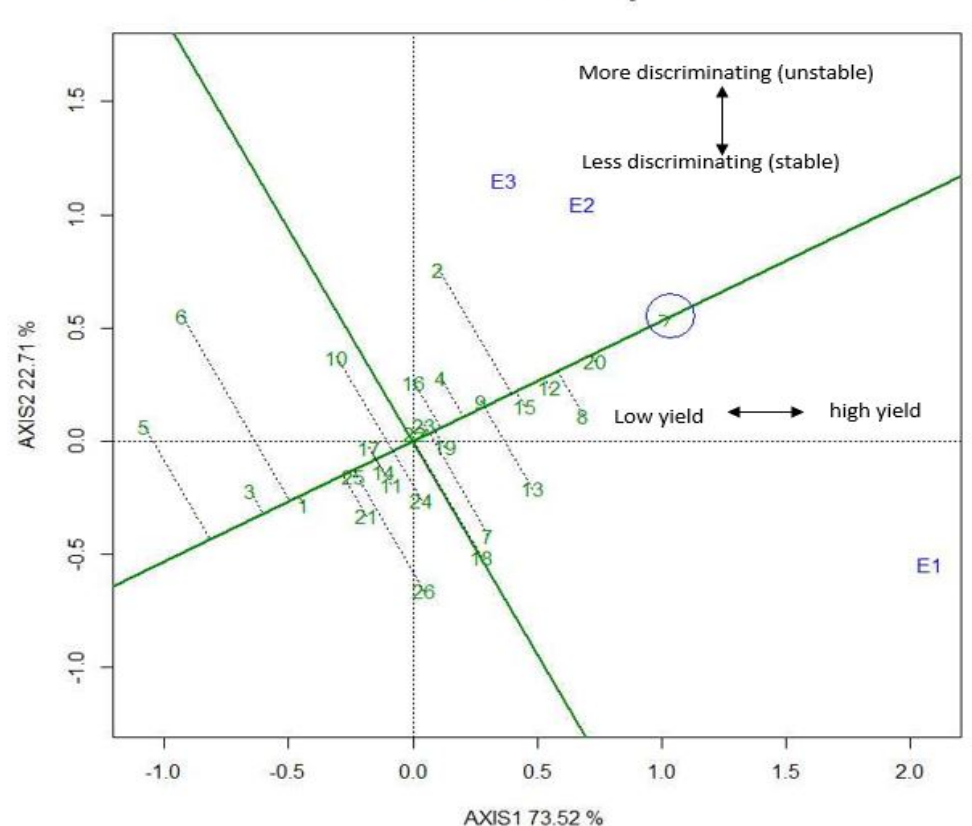
Figure 5. The vector view of the GGE biplot showing mean performance vs. stability of the hybrid combination.